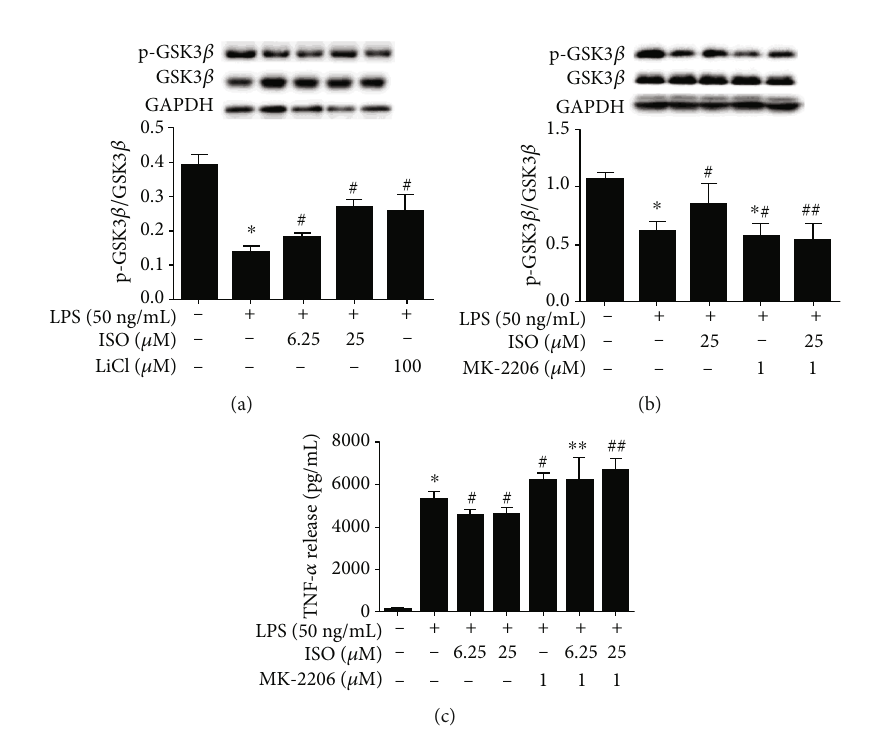
RAW264.7 cells were treated with isoorientin (6.25 and 25 μ M) without or with LiCl (0, 25, and 100 μ M) for 30min and then stimulated with LPS (50ng/mL). After 8h stimulation, cell supernatants were collected, and the levels of TNF- α were detected by ELISA. The data were expressed as mean ± SEM ( n = 3 , 3 replicates). a P < 0 : 05 in comparison with the LPS group.